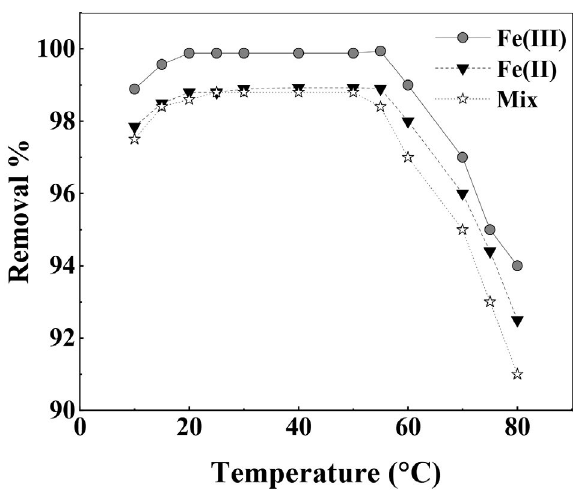
Fig. 6. Effect of temperature on the adsorption Fe(III) and/or Fe(II). Conditions: flow rate = 5.0 mL min –1 ; pH = 4.0; particle size = 100 BSS Table 1. Langmuir, Freundlich, Temkin, and multilayer isotherm model constants for the adsorption of Fe(II) and Fe(III) ions Metal ion